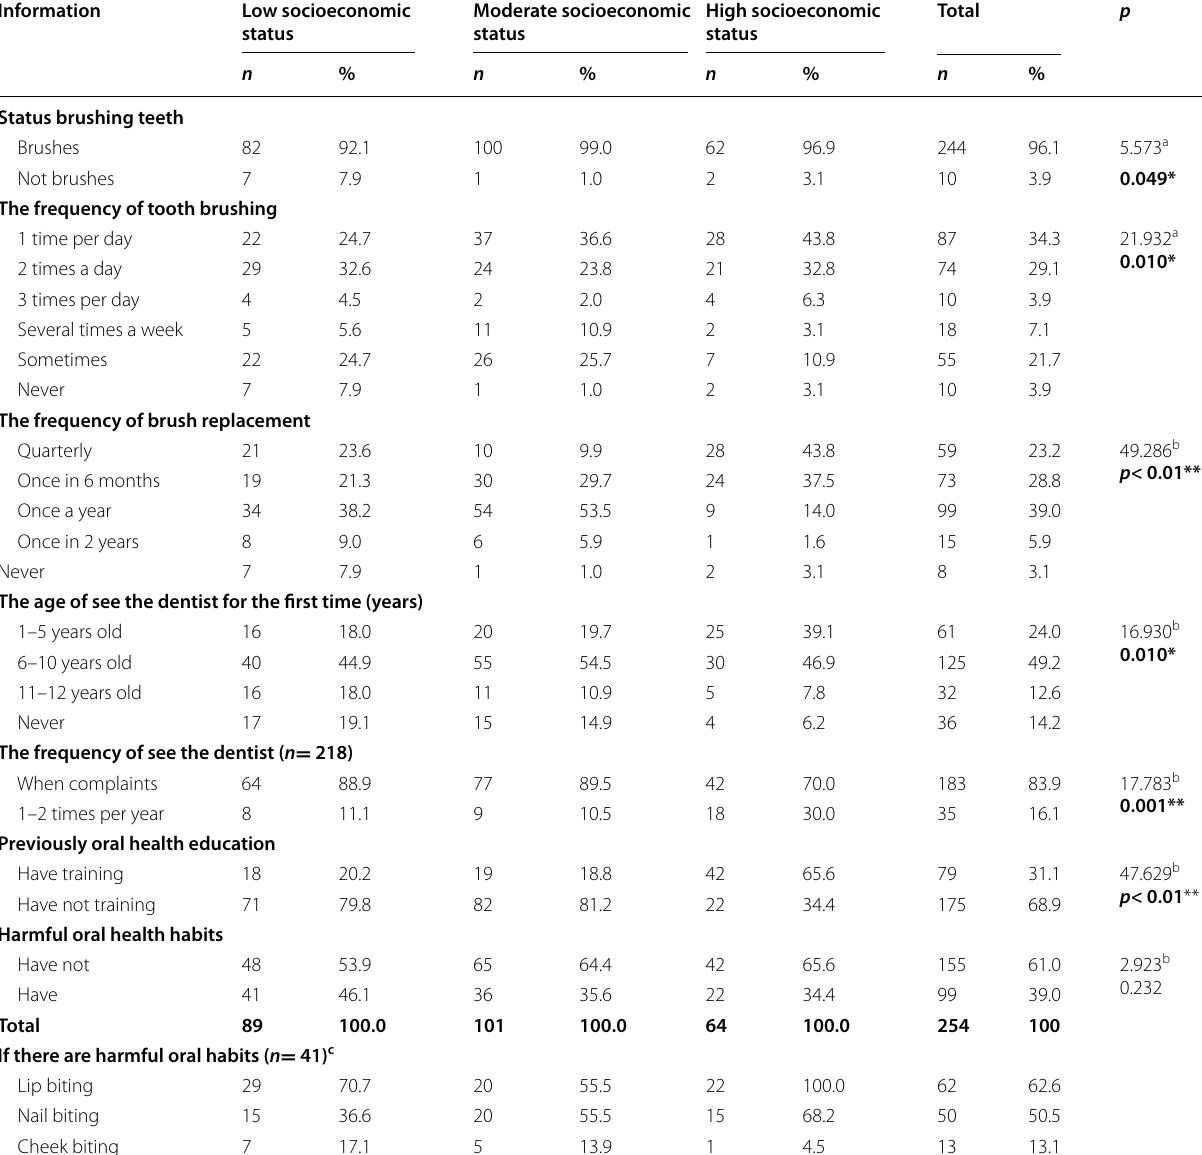
Table 2 Information on oral and dental health of